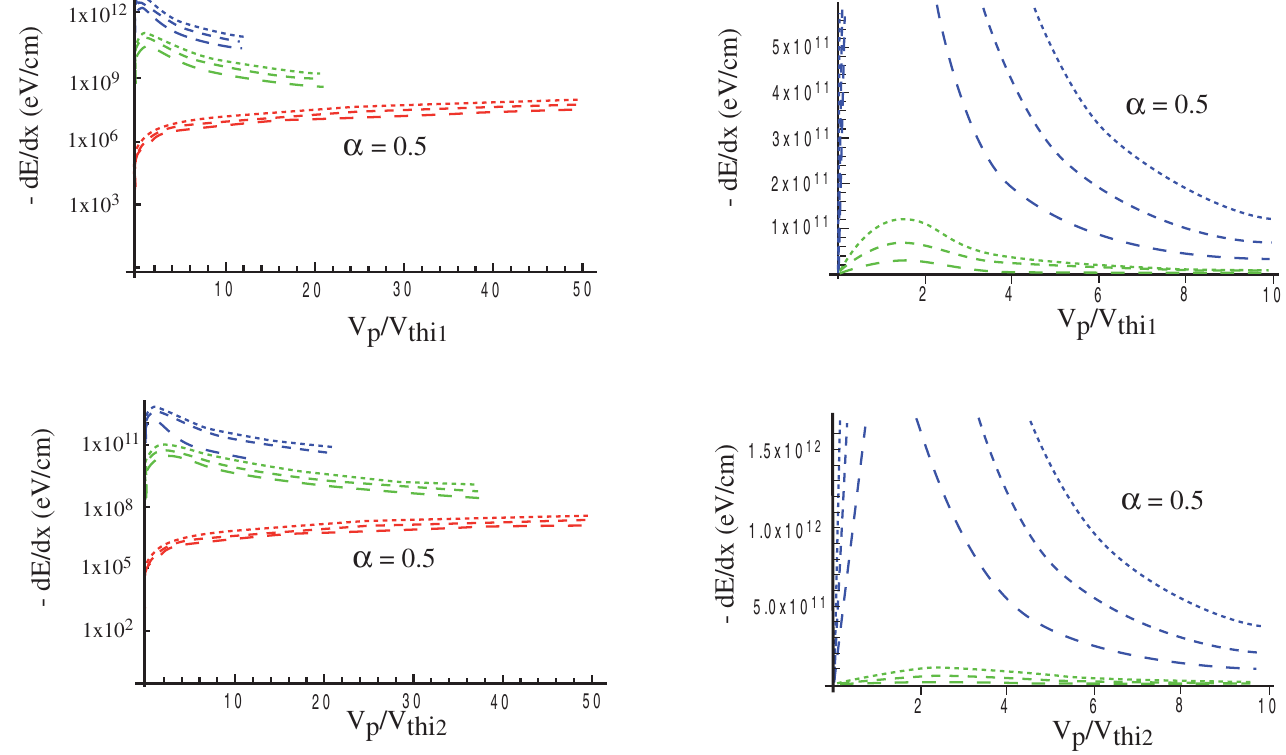
FIG. 8. (Color) Proton (cid:1) dE=dx ( eV = cm ) with respect to V p =V thi in a He 2 þ - C 6 þ BIM at n e ¼ 10 26 e cm (cid:1) 3 with T ð keV Þ ¼ ( ) 1, ( ) 2 ( ) 5. (cid:1) ¼ He 2 þ concentration. Dark gray (red) denotes e stopping, light gray (green) pertains to He 2 þ stopping, and black (blue) to C 6 þ stopping.